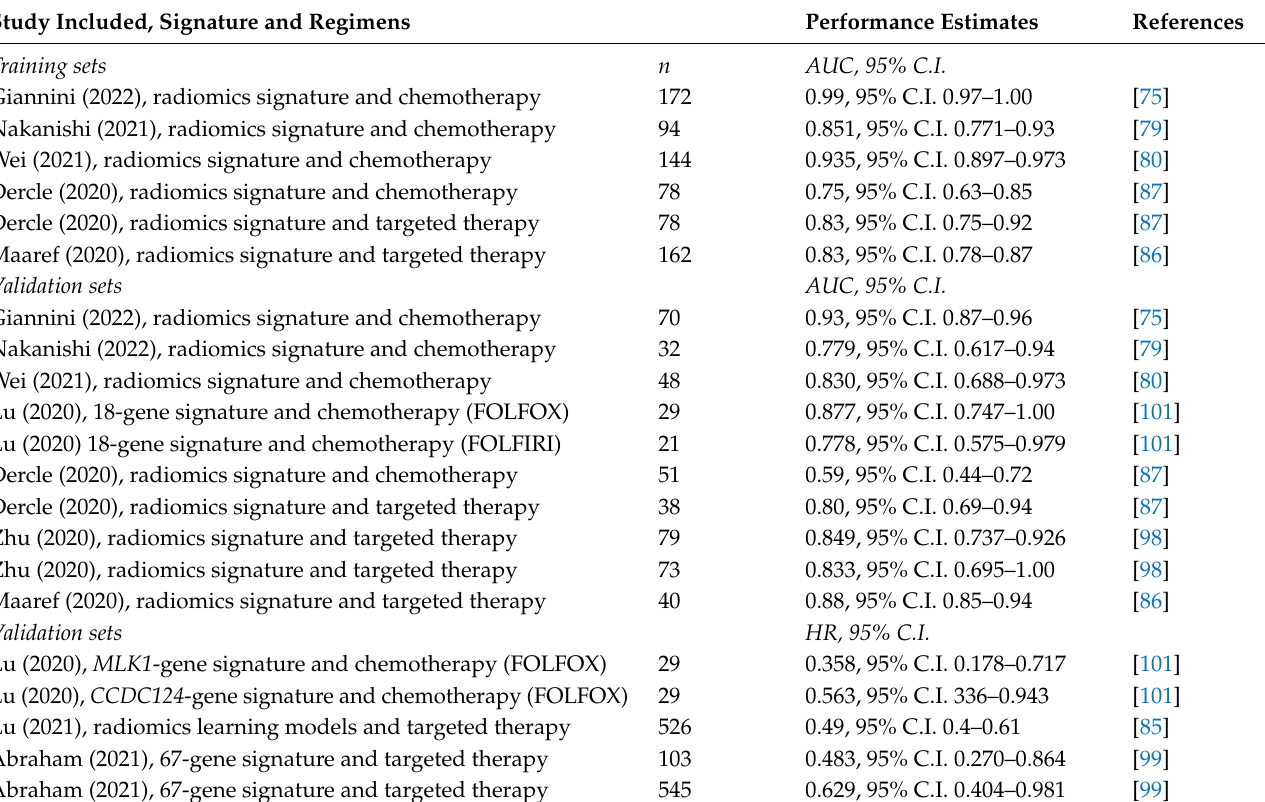
Table 5. The 21 artificial intelligence models reporting the estimates of receiver operating character- istic curve (AUCs) and/or hazard ratios (HRs) and 95% Confidence Intervals (C.I.) for evaluating predictive response or overall survival included in the meta-analysis. Classifiers, cytotoxic chemother- apy, targeted therapy, population size, AUCs, HRs and 95% C.I. in training and/or validations sets are